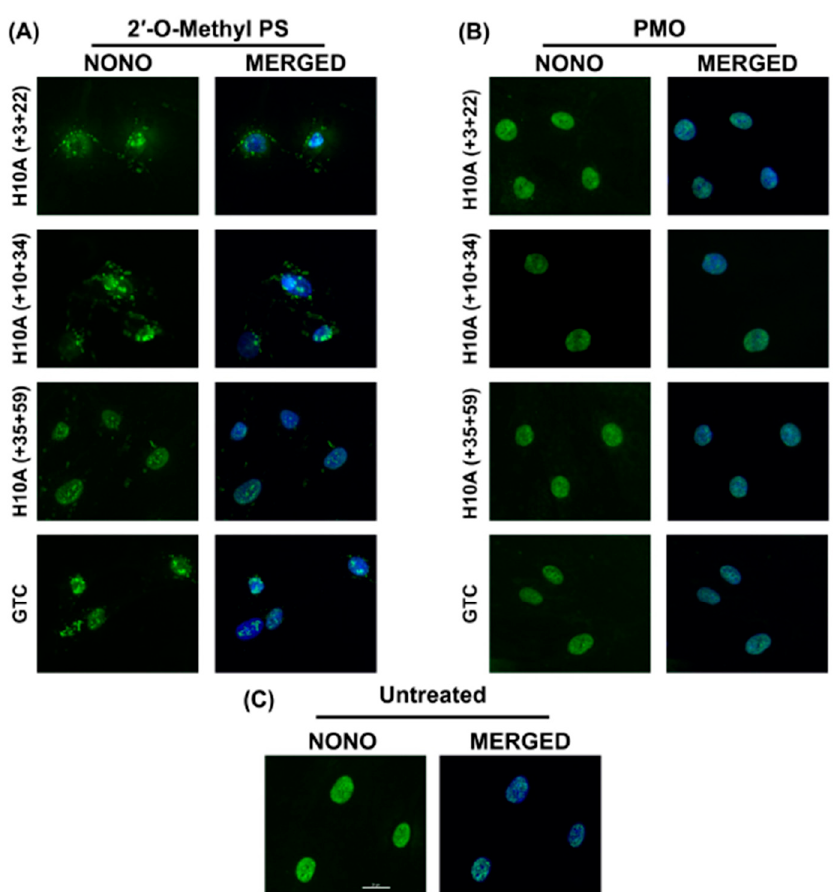
Figure 4. Immunofluorescent labelling of paraspeckle protein NONO in transfected healthy fibroblasts. ( A ) Immunolabelling of primary normal human fibroblasts following transfection with various 2 ′ -Me PS AO lipoplexes at a concentration of 400 nM. Cells were fixed 24 hrs following transfection. Staining of the paraspeckle protein NONO shows sequestration and aggregation of NONO in various subcellular locations. ( B ) Immunofluorescent labelling of NONO following Endoporter transfection of primary normal human fibroblasts with various PMOs at concentrations of 10 or 5 μ M. Cells were fixed 24 hrs following transfection. ( C ) Untreated (control) showing endogenous subcellular distribution of NONO. GTC = Gene Tools Control sequence. Scale bar is 20 μ m. ( D ).